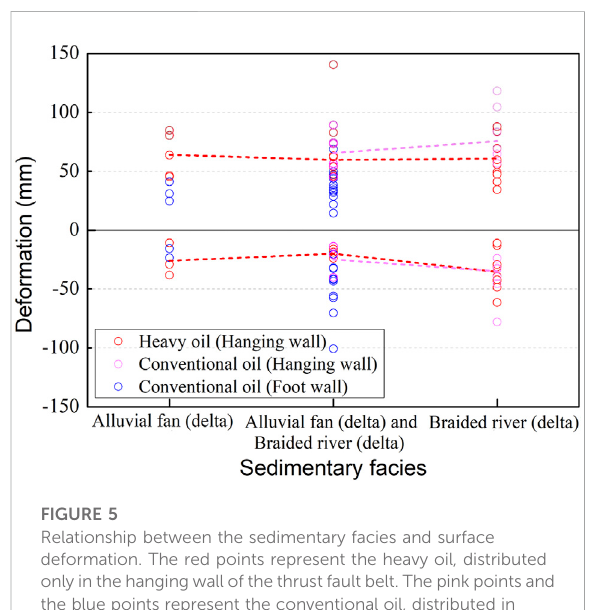
FIGURE 5 Relationship between the sedimentary facies and surface deformation. The red points represent the heavy oil, distributed only in thehanging wall of thethrustfault belt. The pink points and the blue points represent the conventional oil, distributed in both hanging wall and foot wall.